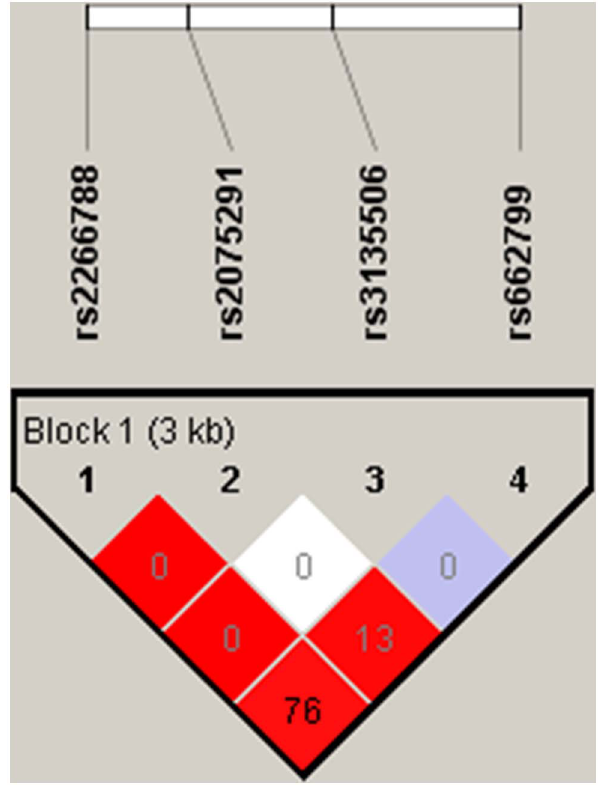
Figure 1. Haploview LD graph of the studied polymorphisms of APOA5 in general Uyghur population. Pairwise linkage disequi- librium is expressed as D’ (different colors) and r 2 (numbers). doi:10.1371/journal.pone.0110258.g001 PLOS ONE |